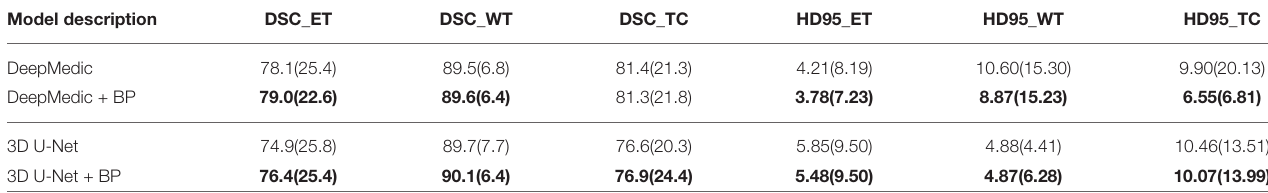
TABLE 2 | Results of the first experiment on the BraTS 2018 validation set.